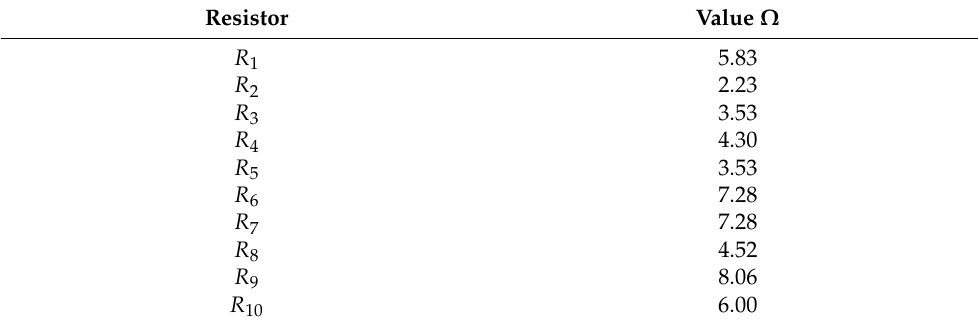
Table 1. Resistor values for the multi-connected grid configuration.